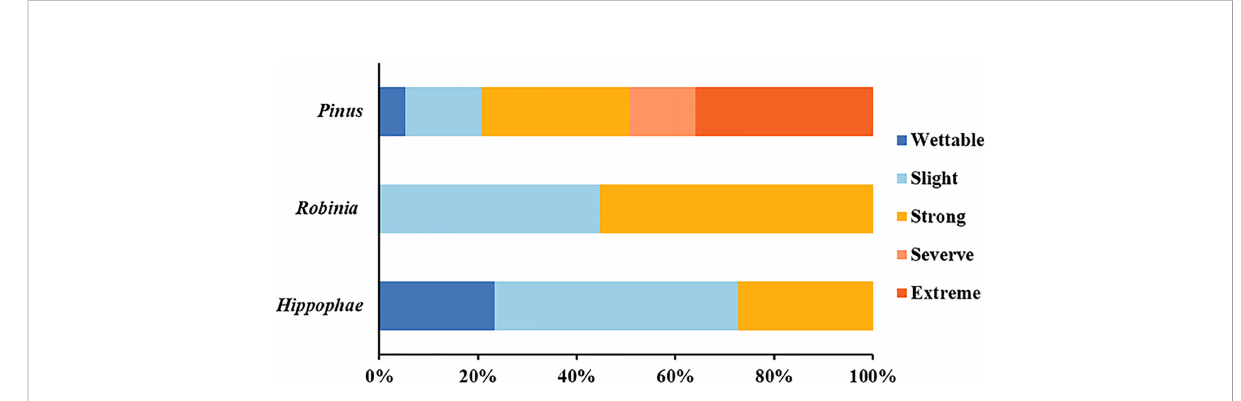
FIGURE 2 Relative frequency of occurrence of each water-repellency class beneath the different plant species (n = 450).